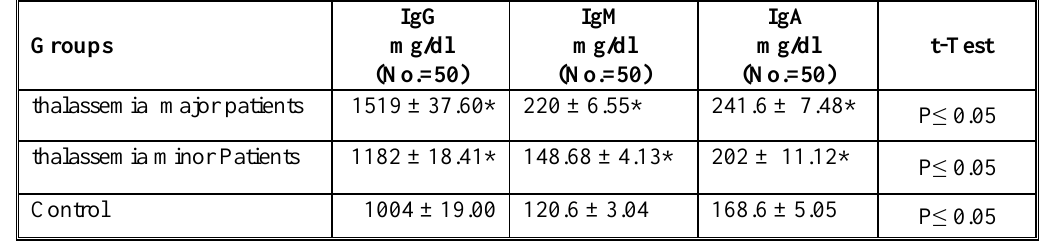
Table 2 : Serum immunoglobulin levels (IgA, IgM and IgG) of control, pathological control and β- thalassemia major